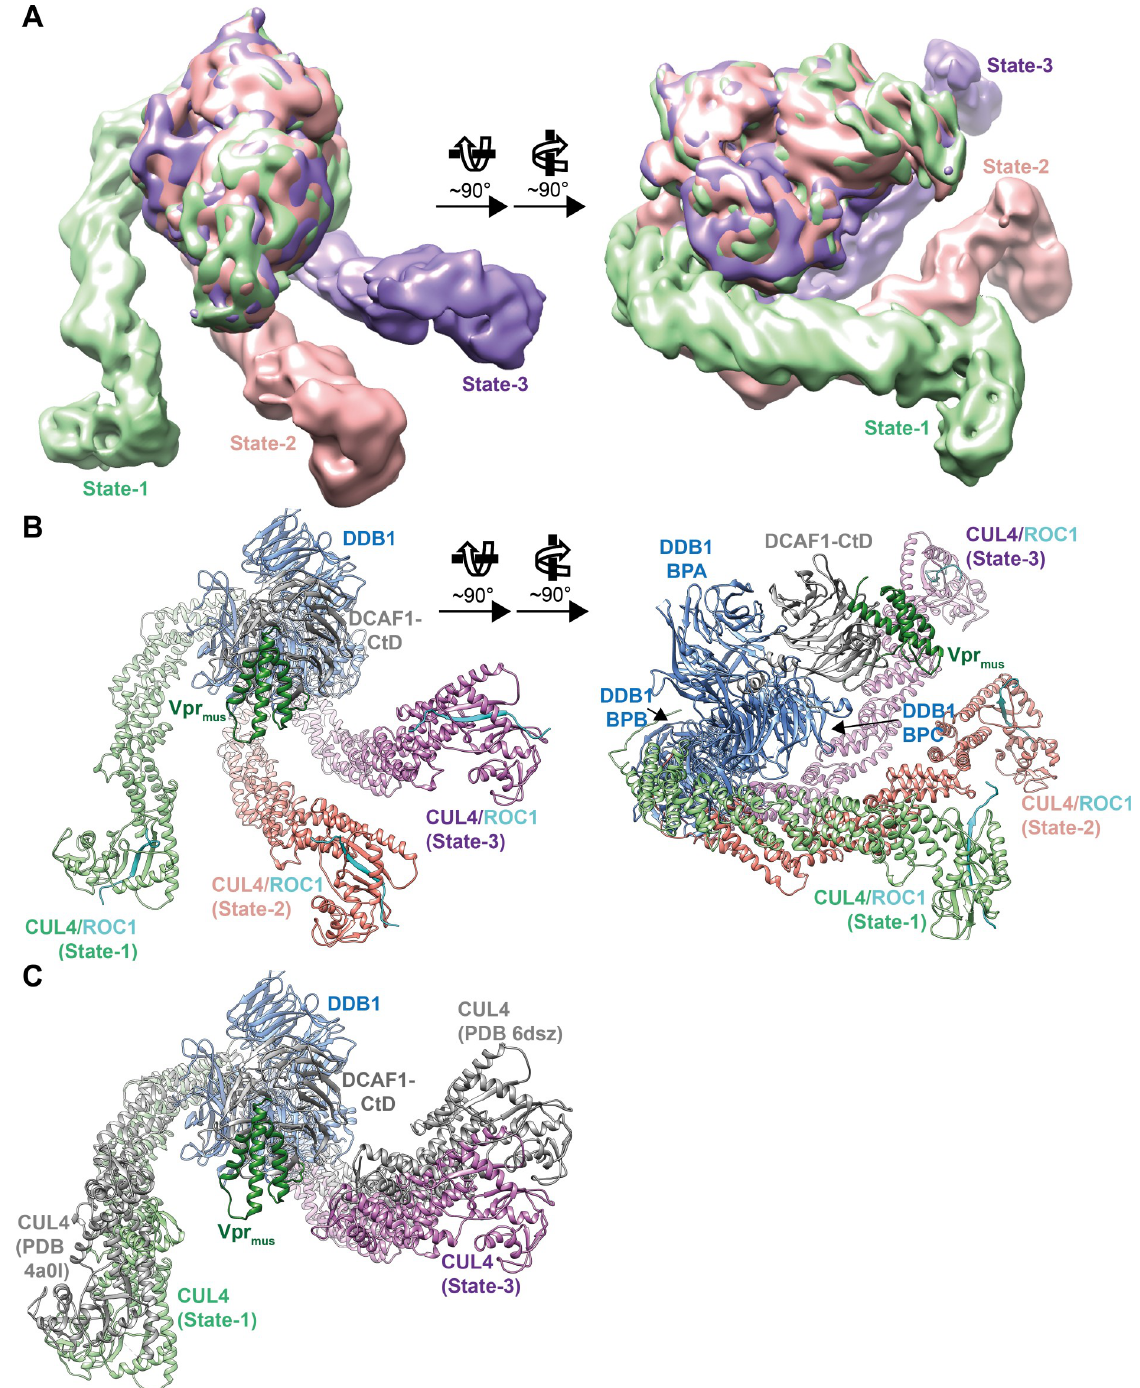
Fig 3. Cryo-EM analysis of CRL4-NEDD8 DCAF1-CtD /Vpr mus /SAMHD1 conformational states. ( A ) Two views of an overlay of CRL4-NEDD8 DCAF1-CtD /Vpr mus /SAMHD1 cryo-EM reconstructions (conformational state-1 –light green, state-2 –salmon, state-3 –purple). The portions of the densities corresponding to DDB1 BPA/BPC, DCAF1-CtD and Vpr mus have been superimposed. ( B ) Two views of a superposition of DDB1/DCAF1-CtD/Vpr mus and CUL4/ROC1 (PDB 2hye) [15] molecular models, which have been fitted as rigid bodies to the corresponding cryo-EM densities; the models are oriented as in A . DDB1/DCAF1-CtD/Vpr mus is shown as in Fig 2A, CUL4 is shown as cartoon, coloured as in A and ROC1 is shown as cyan cartoon. ( C ) Comparison of outermost CUL4 stalk orientations observed in the cryo- EM analysis presented here (states-1 and -3, coloured as in B , show 119.5˚ rotation of DDB1 BPB) to the two most extreme stalk positions present in previous crystal structures (PDB 4a0l [13], PDB 6dsz [123], coloured grey, show 143.4˚ DDB1 BPB rotation). https://doi.org/10.1371/journal.ppat.1009775.g003 PLOS Pathogens| https://doi.org/10.1371/journal.ppat.1009775 August 2,